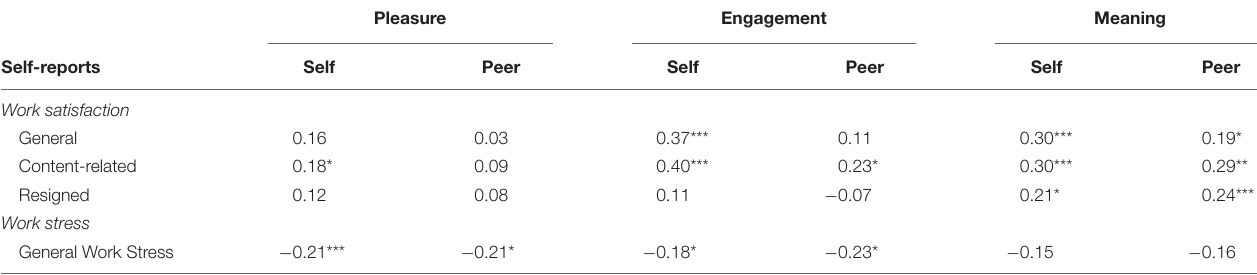
TABLE 1 | Correlations (controlled for age and gender) between self- and peer-reported orientations to happiness, types of work satisfaction, and work stress.